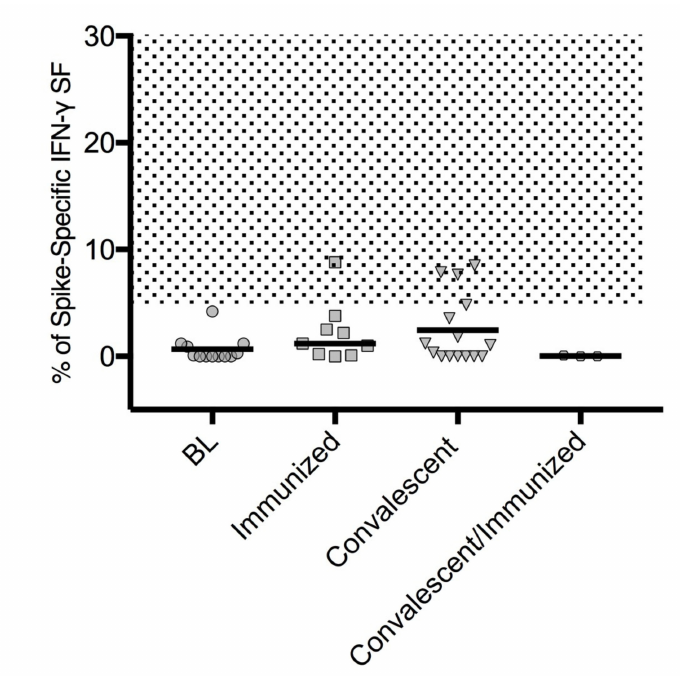
Figure 3. SARS-CoV-2 T cell-specific response in CVID patients. Data are shown as the percentage of increment IFN γ production after T cells stimulation with the spike SARS-CoV-2 protein at BL ( n = 9), after immunization (immunized, n = 9), after COVID-19 recovery (convalescent, n = 15), and in conva- lescents after immunization (convalescent/immunized, n = 3). Percentage distributions and medians (horizontal lines) are shown. The dotted area represents the IQR range in HD after immunization as previously reported [26]. Values were compared by two-tailed Mann–Whitney U-test or Wilcoxon matched-pairs signed-rank test (comparison between convalescents and convalescents/immunized only). Abbreviations: BL, baseline; IFN- γ , interferon gamma spot-forming